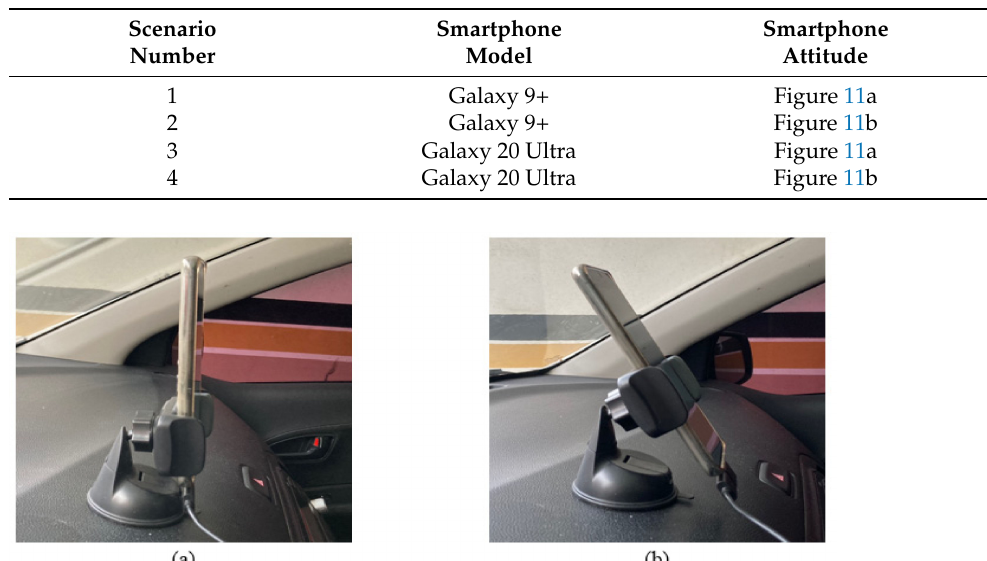
Table 1. Experimental scenario settings.